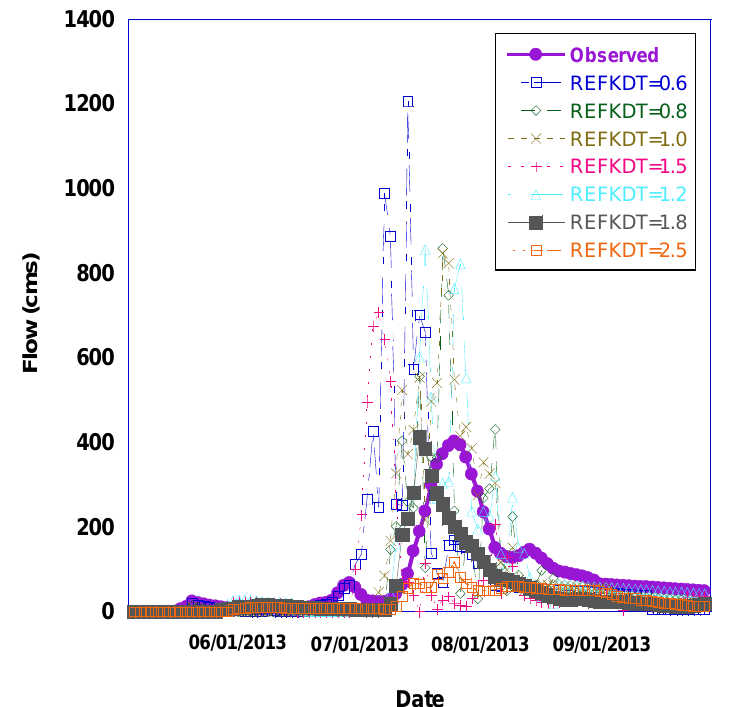
Figure 4. WRF-Hydro different REFKDT (runoff/infiltration rate) and REFDK values (saturation hydraulic conductivity) at the Ayalon basin.